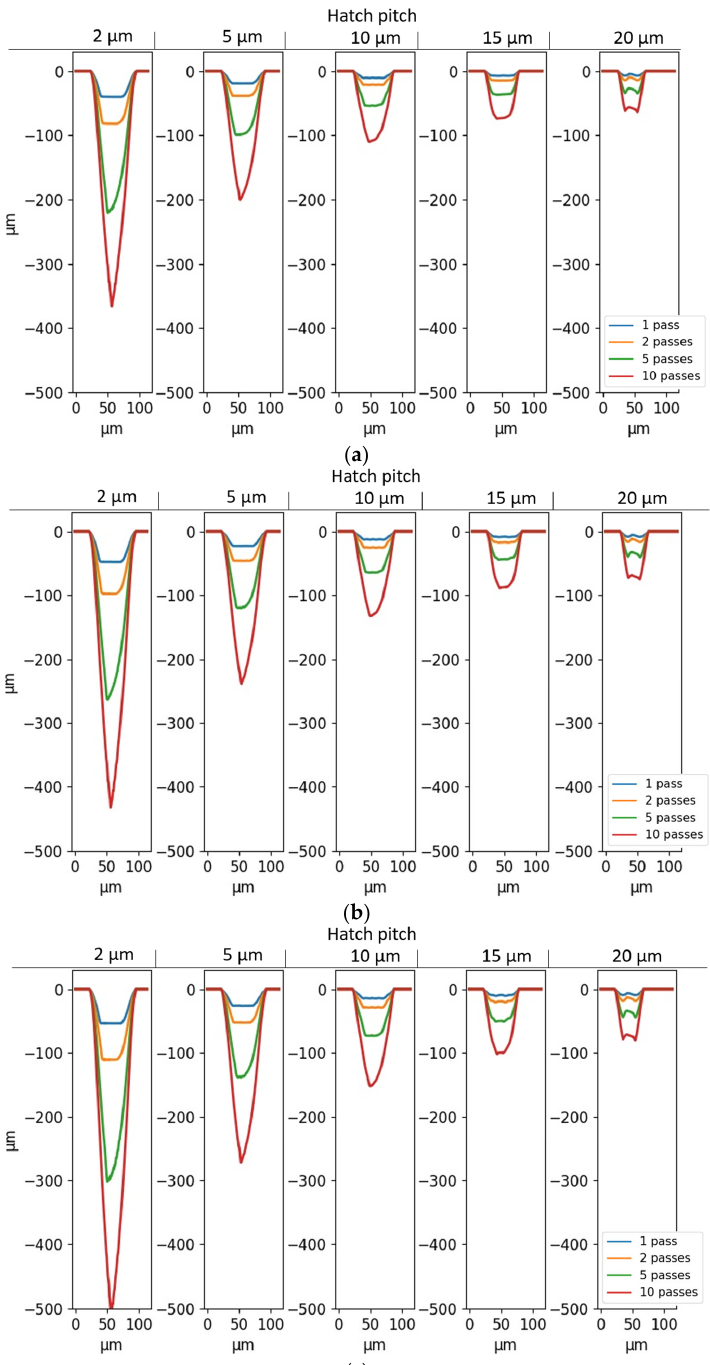
Figure 11. Simulated cross ‐ sections of unidirectional grooves with geometry ‐ dependent threshold fluence ( c F = 0.043) and reflectivity, as a function of hatch pitch and the number of passes. ( a ) c R = 1; ( b ) c R = 5; ( c ) c R =